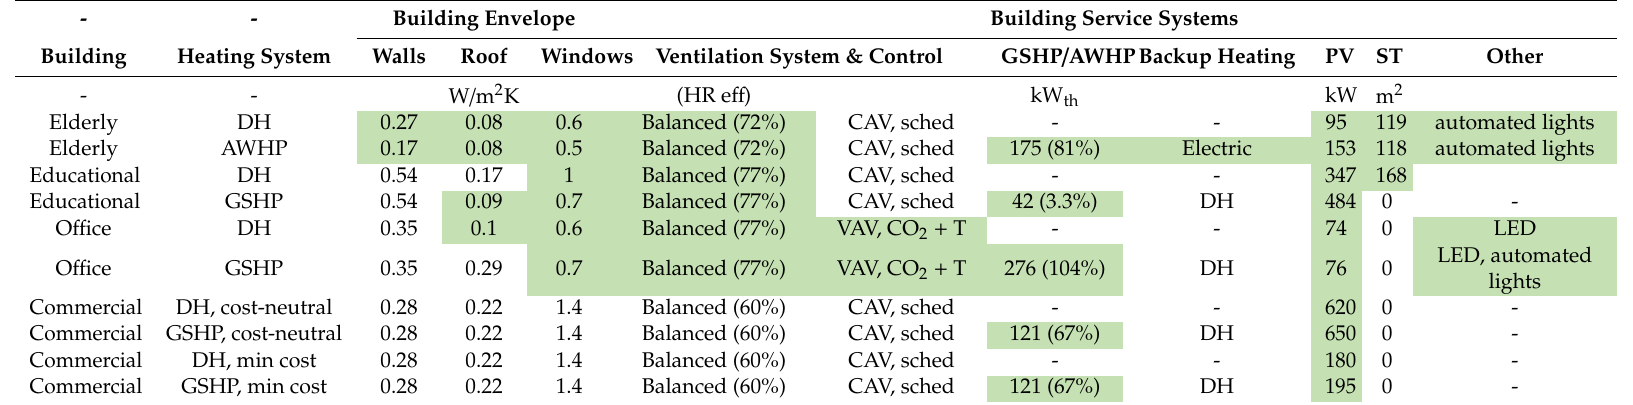
Improvements over the reference case have been highlighted in